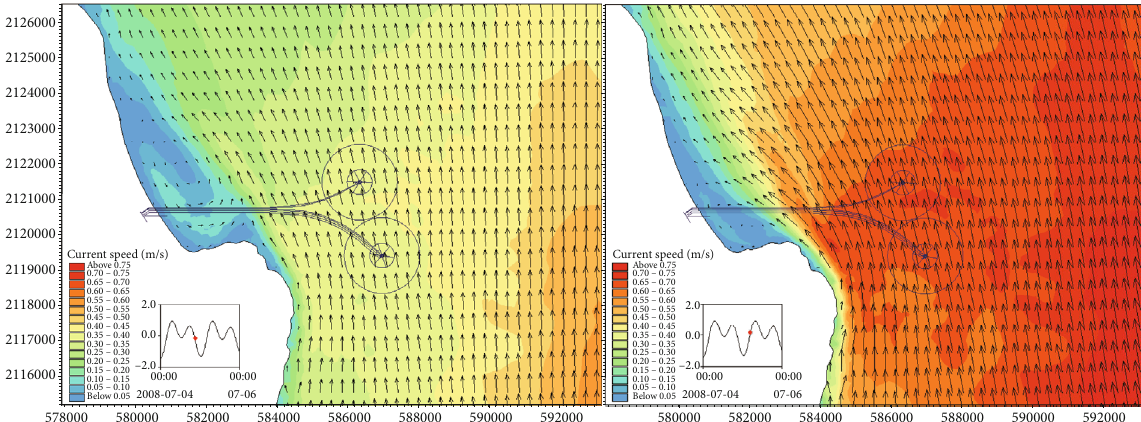
Figure 8: Depth-averaged current velocity during spring tide of the summer monsoon (left: ebb and right: fl ood tides).